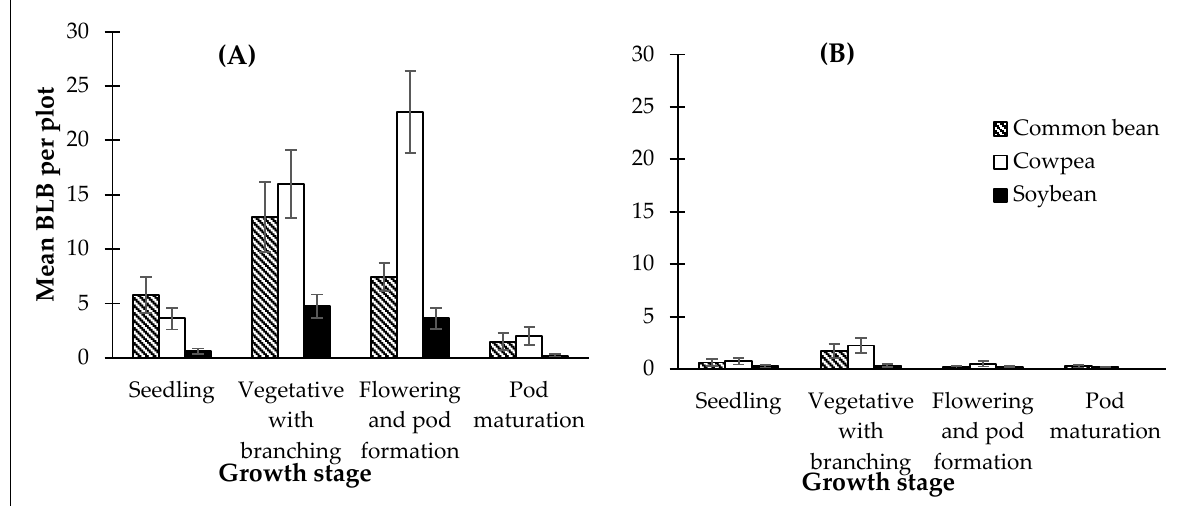
Figure 1. Abundance of adult Ootheca spp. at different growth stages of common bean, cowpea, and soybean in Arua ( A ) and Lira ( B ), averaged over seasons. Error bars represent standard errors. 3.3. Seasonal Abundance of BLBs, Leaf Damage, and Incidence Fir Common Bean, Cowpea Soybean and